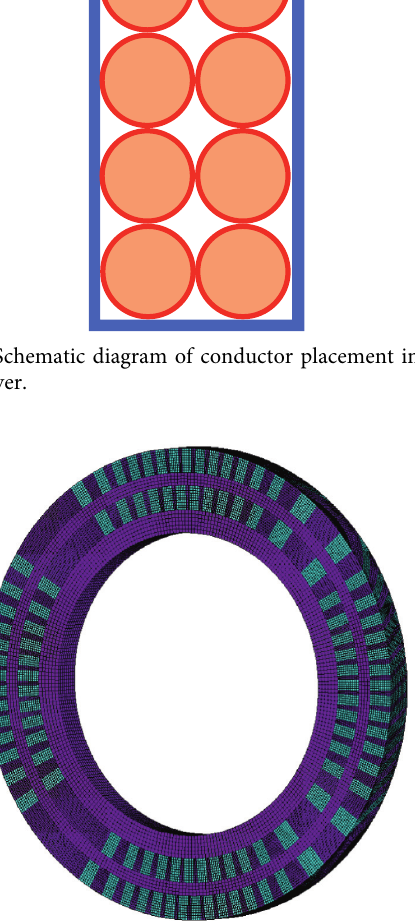
Figure 5: The 3D periodic symmetry model for structural analysis in ANSYS for CCT quadrupole with two layers.